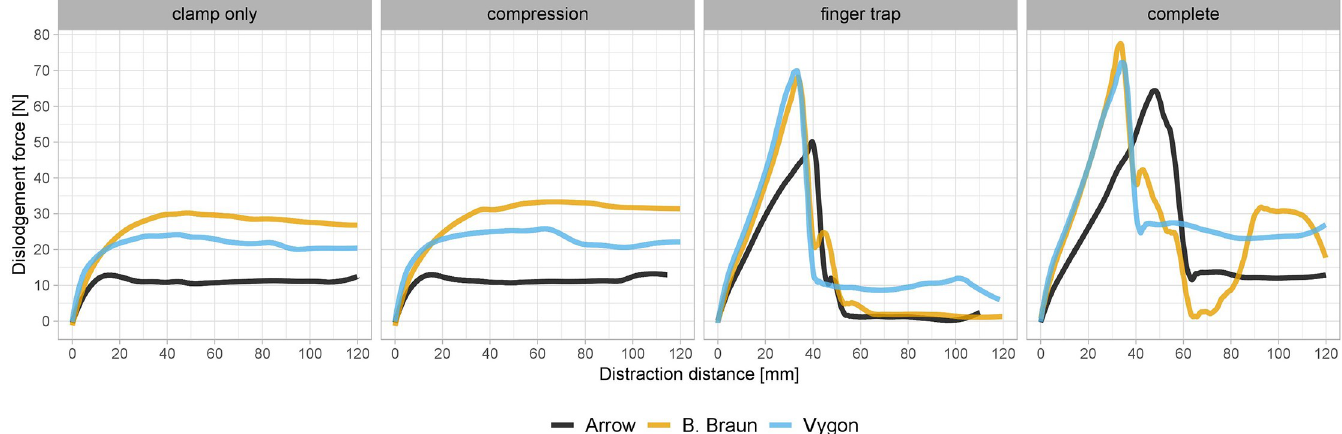
Fig 4. Distance-force diagrams. Median forces and distances of all investigated fixation suture techniques. A steady state of dislodgement force occurs in the “clamp only” and “compression” fixation technique. The catheter is being pulled throughout the fixation clamp in these two approaches. In contrast, the dislodgement force increases steadily in the “finger trap” and “complete” fixation technique until a rupture of the suture or catheter occurs. After the rupture, the dislodgement force is close to zero in the “finger trap” approach since no clamp is being used. In contrast, the dislodgement force in the “complete” fixation technique is similar to the “clamp only” and “compression” approach since the catheter is still secured by the clamp after the rupture of suture. The second peak observed in “finger trap” and “complete” technique of Arrow and B. Braun appears when the catheter ruptured before the suture.